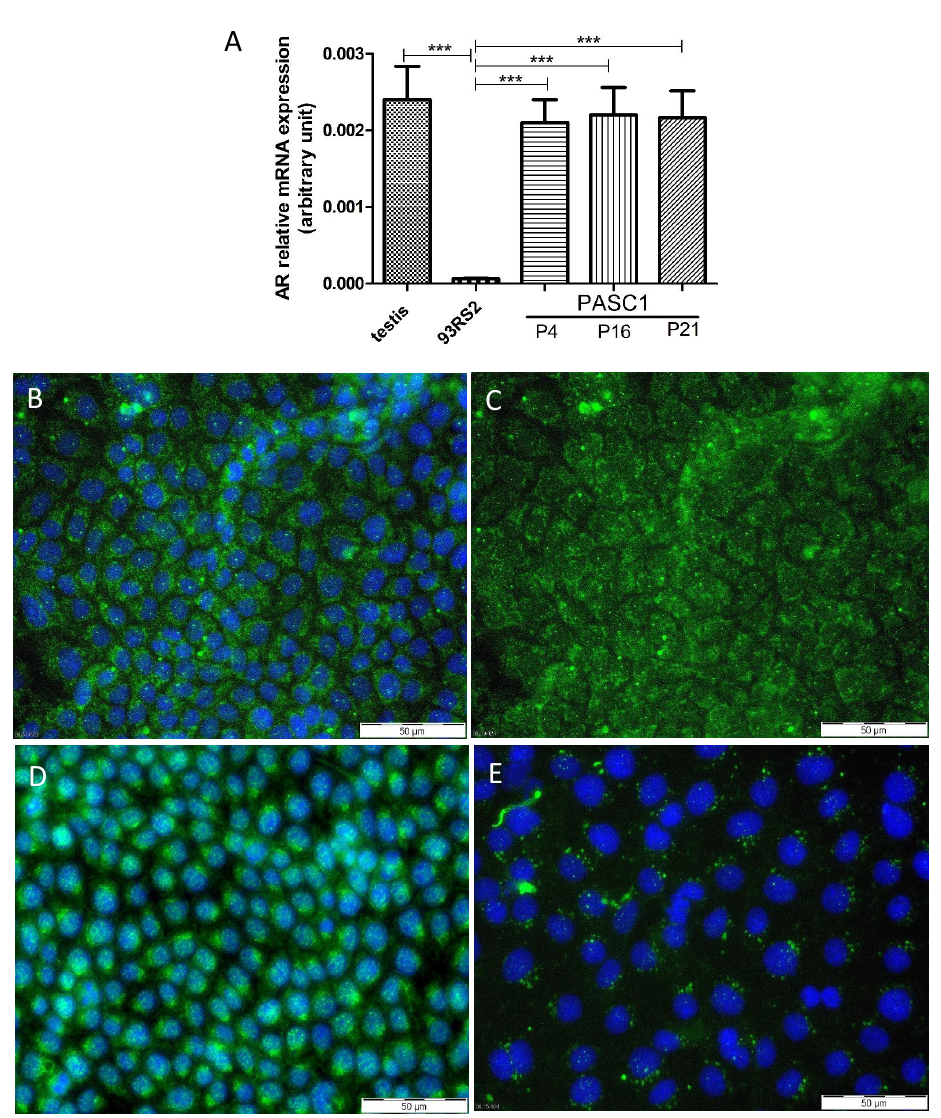
Figure 7. Conditionally reprogrammed PASC1 express the androgen receptor (AR) on the mRNA ( A ) and protein level ( B – D ) in passages P4 and P16. The mRNAs of 93RS2 and adult rat testis were used as negative and positive controls, respectively. The majority of AR (green) was detected in the cytoplasm of PASC1 and rarely in the nuclei ( B , C ) of untreated cells. After the treatment with testosterone, the AR was visible in the nuclei and concentrated in a perinuclear region ( D ). The negative control with Alexa Fluor showed a negligible background ( E ). DAPI was used to stain the nuclei (blue). Each bar represents the mean ± SEMs of three independent experiments performed in duplicates; *** p <